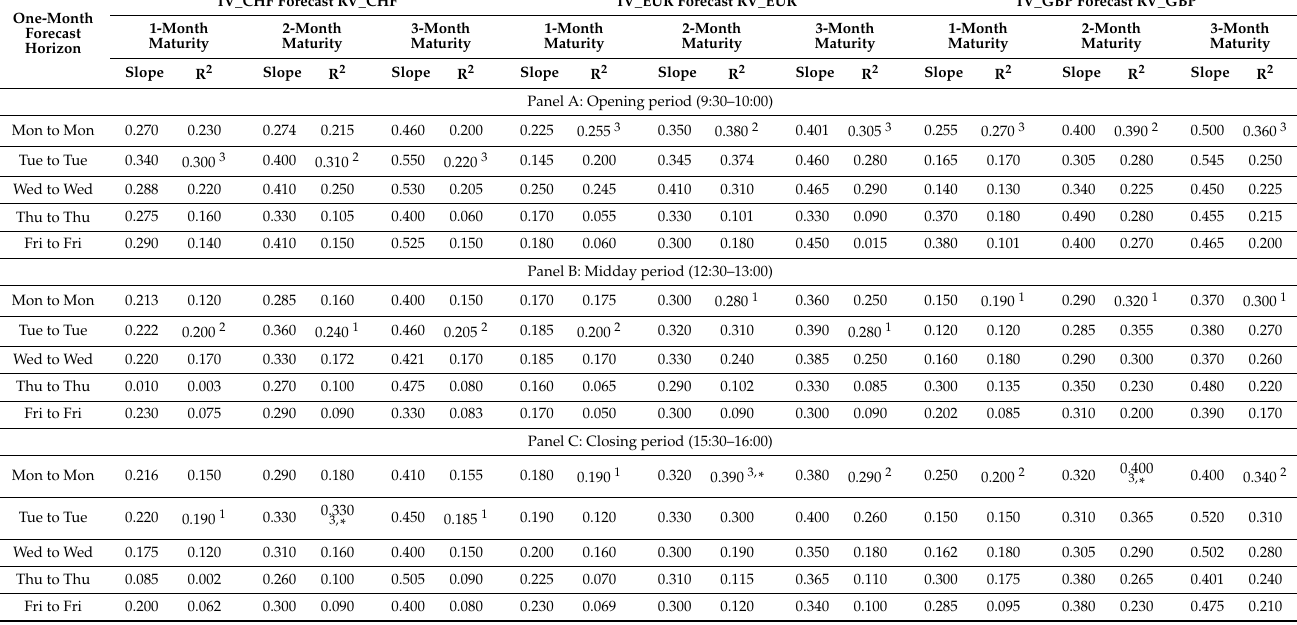
Table 3. IV forecast RV for one-month forecast